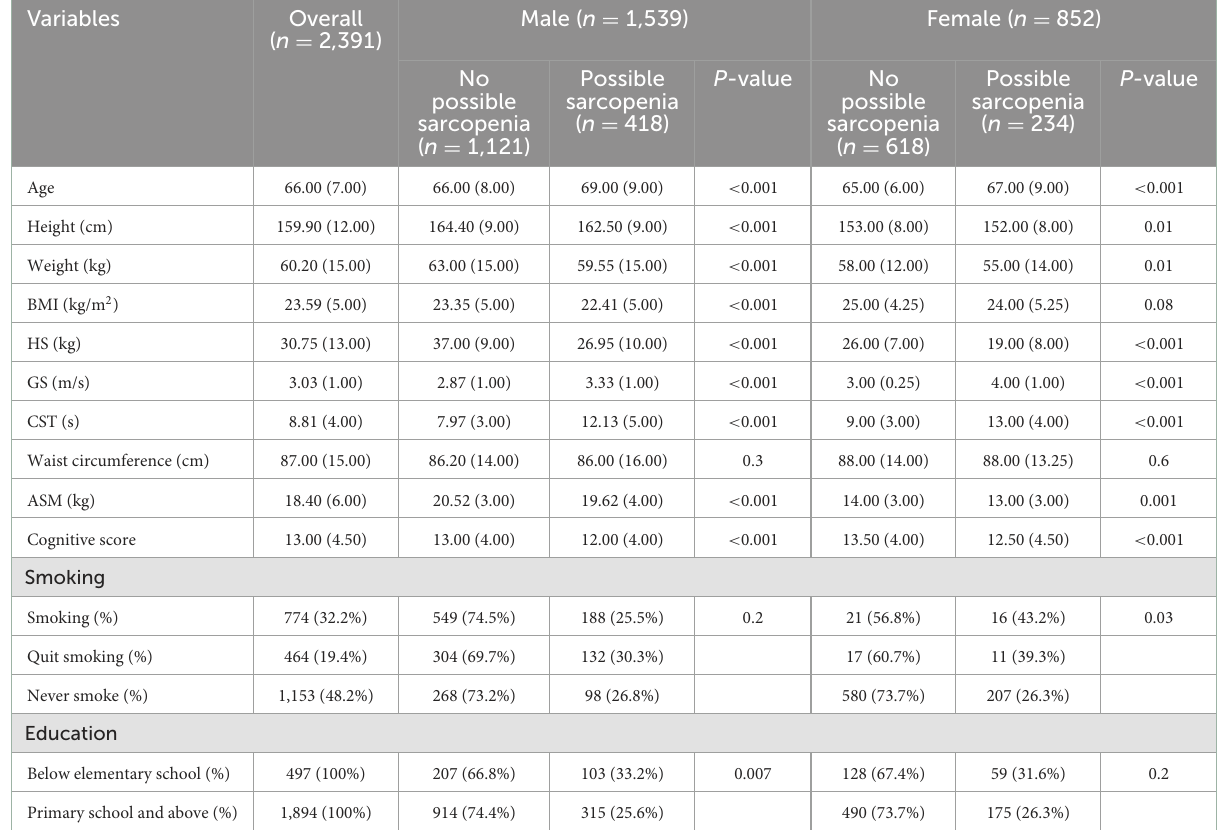
TABLE 1 Participant characteristics according to sarcopenia status ( n =